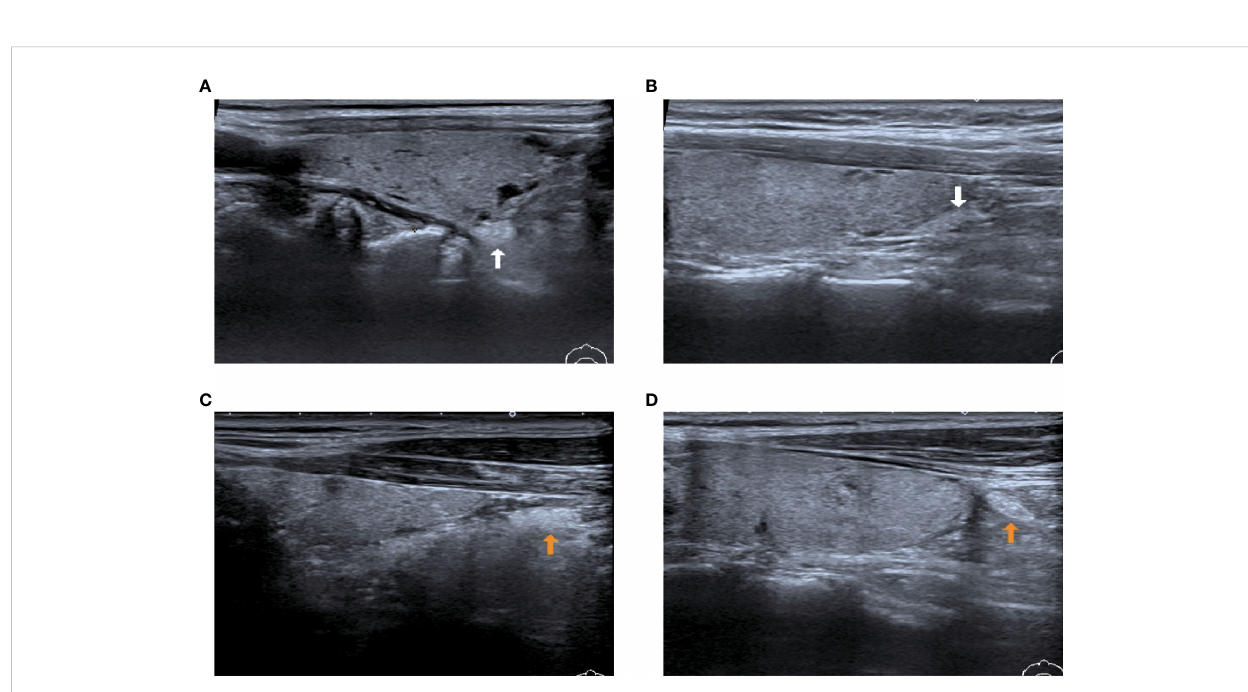
FIGURE 6 Two types of IPG observed by preoperative ultrasound images. (A, B) : White arrow shows type I PG, where the PGs are in close contact with the thyroid gland; (C, D) : Yellow arrow shows type II PG, where the PGs are free of the thyroid gland and not in close contact with the thyroid gland.